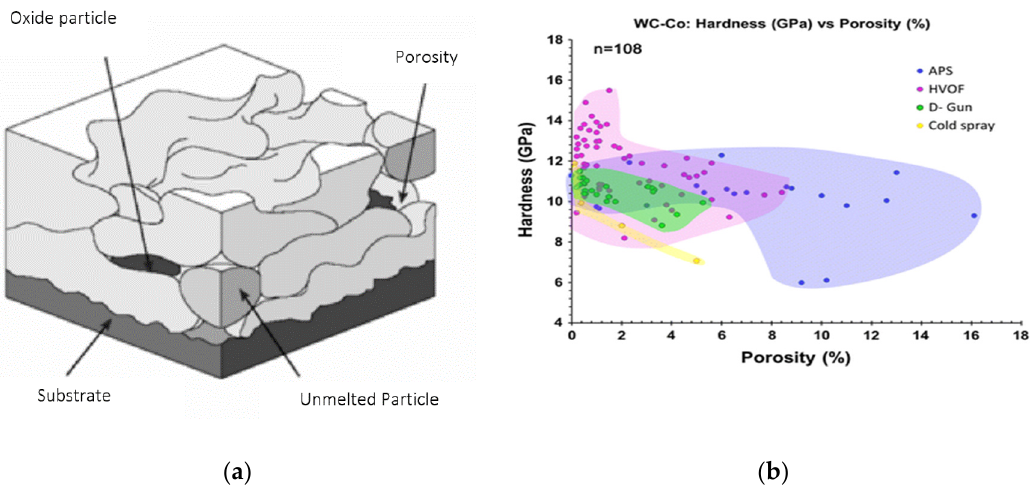
Figure 4. ( a ) Schematic image of a thermally sprayed coating with layered structure [37]; Reprinted with permission from [37]; 2006 Faculty of Mechanical Engineering; ( b ) Variation in hardness and porosity of cemented carbide WC-Co coatings deposited by air plasma spray (APS), velocity oxy-fuel (HVOF), detonation gun deposition (D-gun), and cold spray [36]. Reprinted with permission from [36]; 2013 Springer Nature.